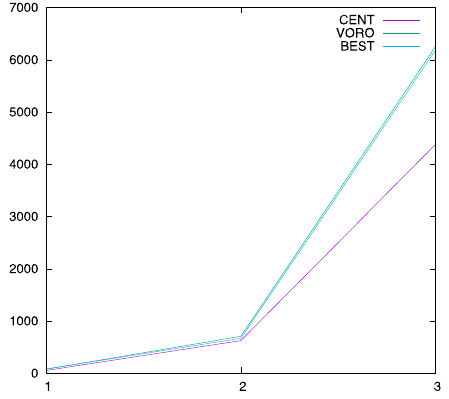
Figure 4. Computer runtime in seconds for the Rossby–Haurwitz case: 1. two-degree resolution; 2. one-degree resolution; and 3. half-degree resolution. CENT, centroidal; VORO, Voronoi; BEST, best.